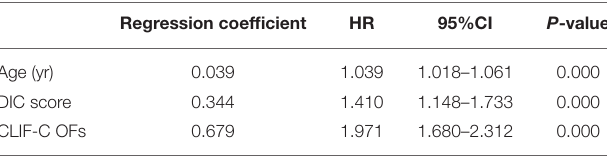
TABLE 2 | Risk factors associated with transplant-free 90-day mortality in patients with HBV-ACLF according to a multivariate Cox PH model. Regression